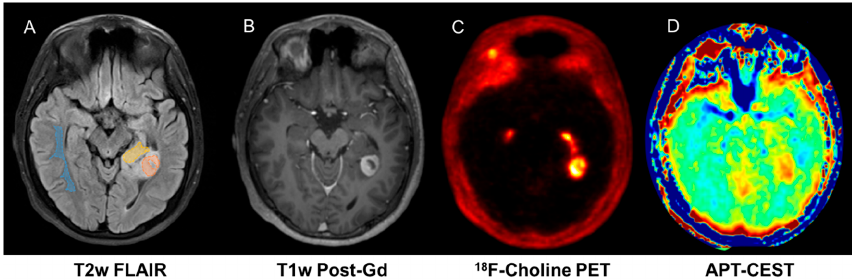
Figure 3. Fifteen-year-old male with pilocytic astrocytoma imaged on hybrid PET/MR which enables exact co-registration of FCho (C) with APT-CEST ( D ) showing correlation in enhancing ( B ; T1 exact co-registration of FCho ( C ) with APT-CEST ( D ) showing correlation in enhancing (( B ), T1 contrast) contrast) and non-enhancing tumour components. ( A , T2 FLAIR). and non-enhancing tumour components. (( A ), T2